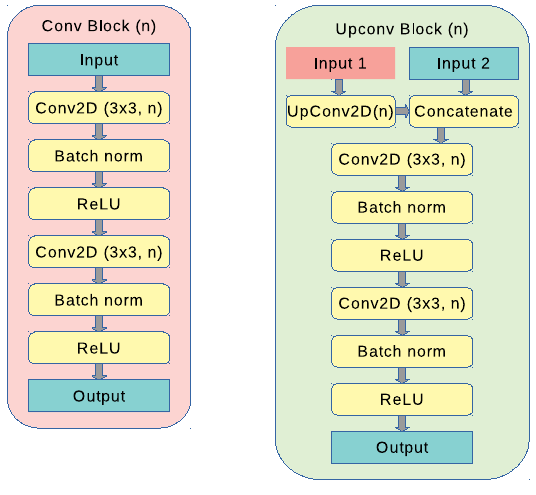
Figure 4. Conv and Upconv blocks of the proposed